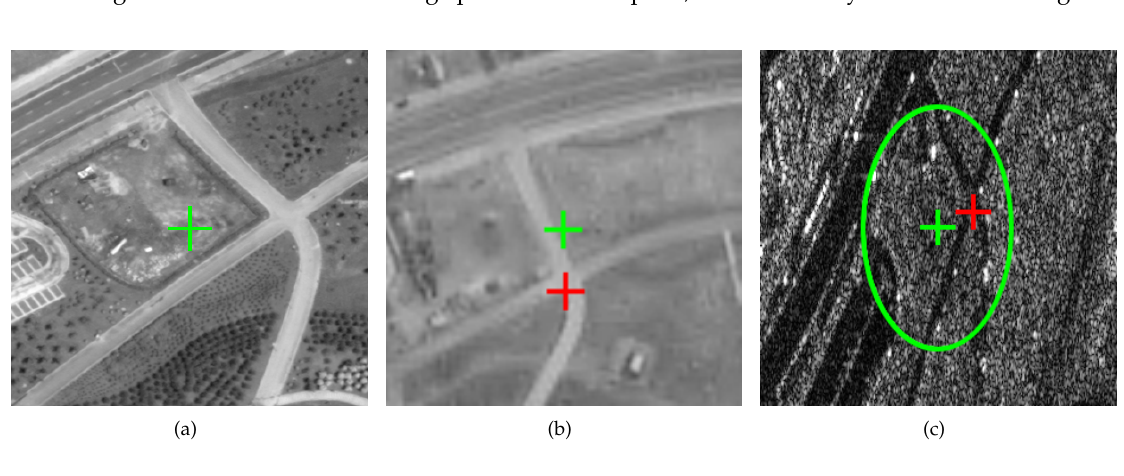
Figure 2. The image point extraction for GLAS footprint: ( a ) digital orthophotograph model (DOM), ( b ) high-resolution (HR) optical image, and ( c ) synthetic aperture radar (SAR) image. The image points calculated by back-projection are indicated by a green cross. The final image points located in obvious texture area are indicated by a red cross. The circle footprint with a diameter of 70 m is marked by a green ellipse (the line resolution is 0.331 m and sample resolution is 0.562 m). The geometric accuracies of